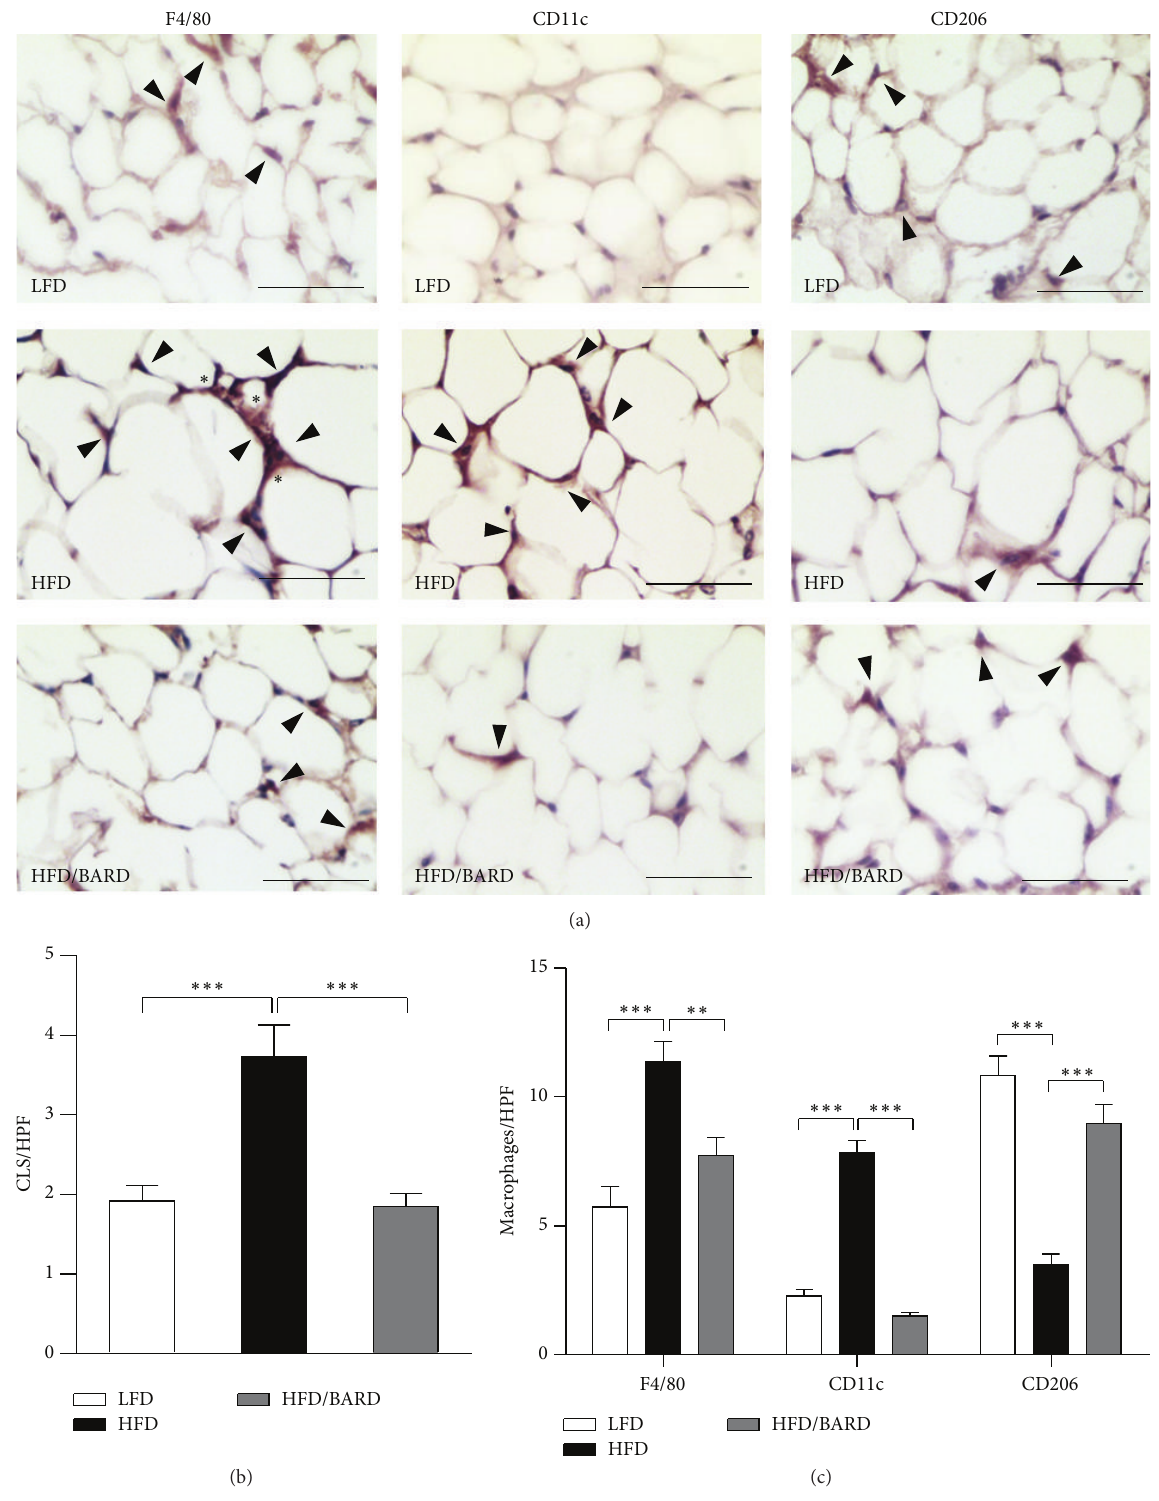
Figure 2: Effect of bardoxolone methyl (BARD) on expression of F4/80, CD11c, and CD206 macrophages in mesenteric adipose tissue of mice fed low-fat diet (LFD), high-fat diet (HFD), and high-fat diet supplemented with BARD (HFD/BARD). (a) F4/80, CD11c, and CD206 stained sections ( × 40). Bar = 50 𝜇 m. The asterisks indicate F4/80 crown-like structures (CLS); the arrow heads demonstrate single F4/80, CD11c, and CD206 positive stained cells. (b) Number of CLS per high power field (HPF). (c) Number of F4/80, CD11c, and CD206 positive cells per HPF. All data are presented as mean ± SEM. ∗∗ 𝑝 < 0.01 ; ∗∗∗ 𝑝 < 0.001